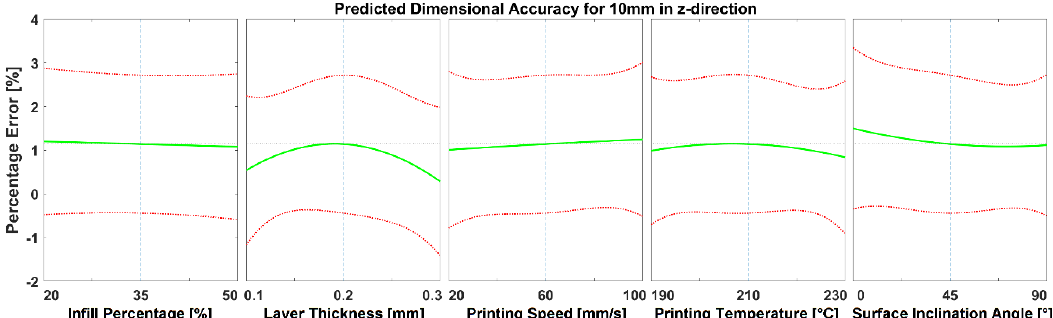
Figure 8. Predicted effects of changes in process parameters on the error% for dimensional accuracy of 10 mm length in the Z direction.